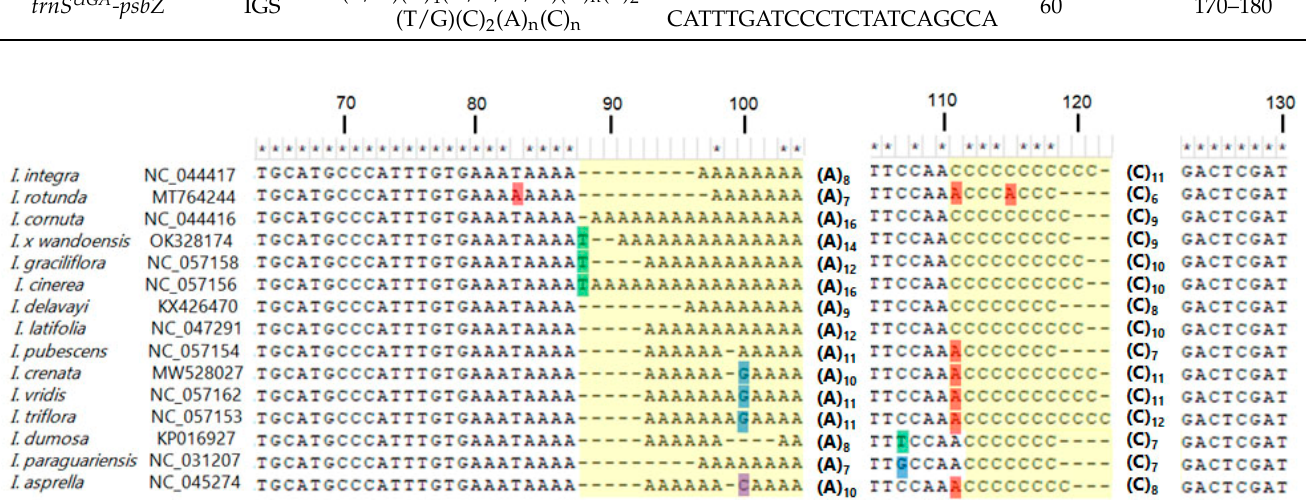
Figure 5. Alignment of a subset of DNA fragments at the simple sequence repeat (SSR) locus trnS UGA -psbZ in 15 Ilex chloroplast genomes. Numbers at the top indicate positions relative to the consensus sequence between 70 and 130 bp. Bold nucleotides in brackets indicate SSR motifs, and the number of repeats is shown. Dashes indicate gaps. Point mutations are highlighted with colored boxes; red: A, green: T, blue: G, and purple: C. Yellow boxes indicate two groups of insertions and deletions, which are considered to be a single mutational event.